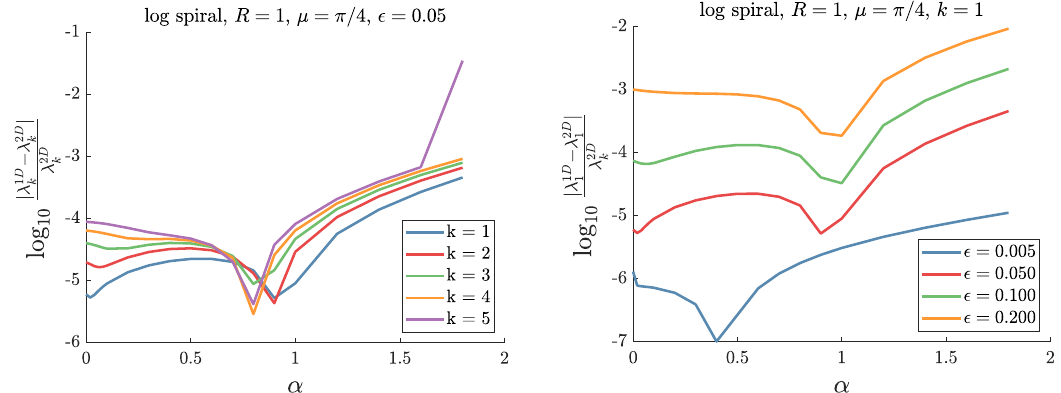
Figure A2. The relative difference between 1D and 2D calculations as a function of α . Left: the first five eigenvalues in the case (cid:101) = 0.05. Right: the first eigenvalue for different values of (cid:101) .